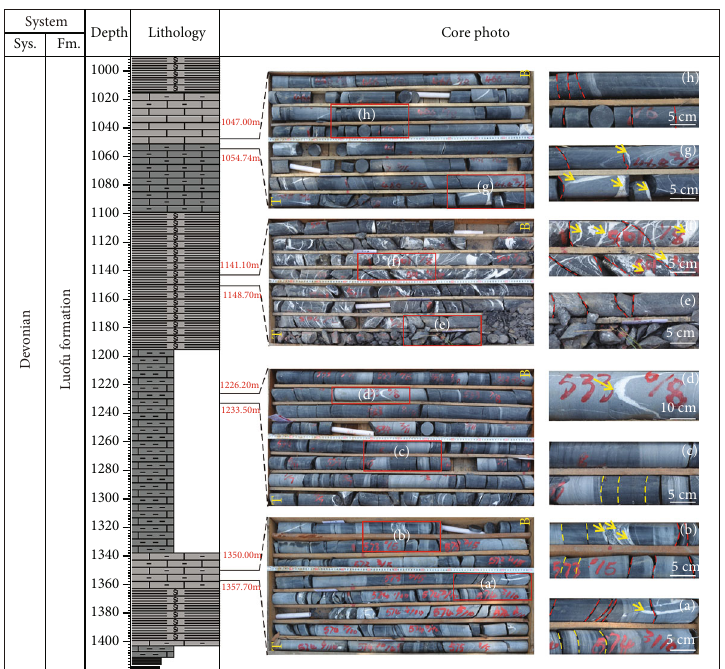
Figure 14: Typical core photos of Middle Devonian Luofu organic-rich shale in well